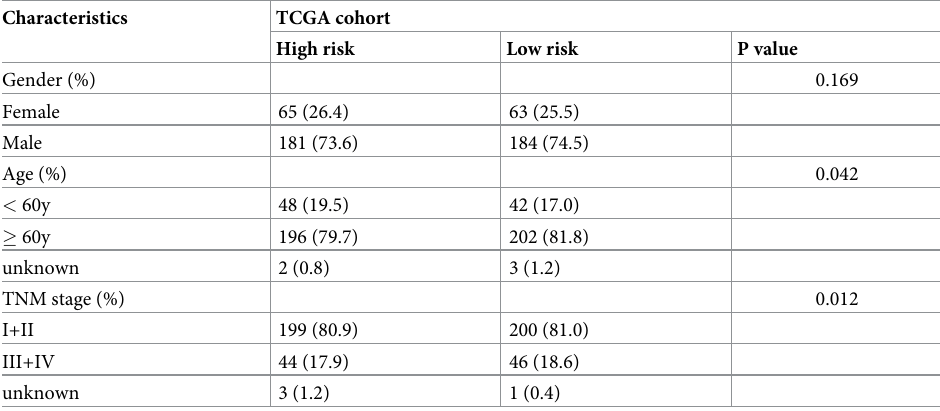
Table 2. Baseline characteristics of the patients in different risk